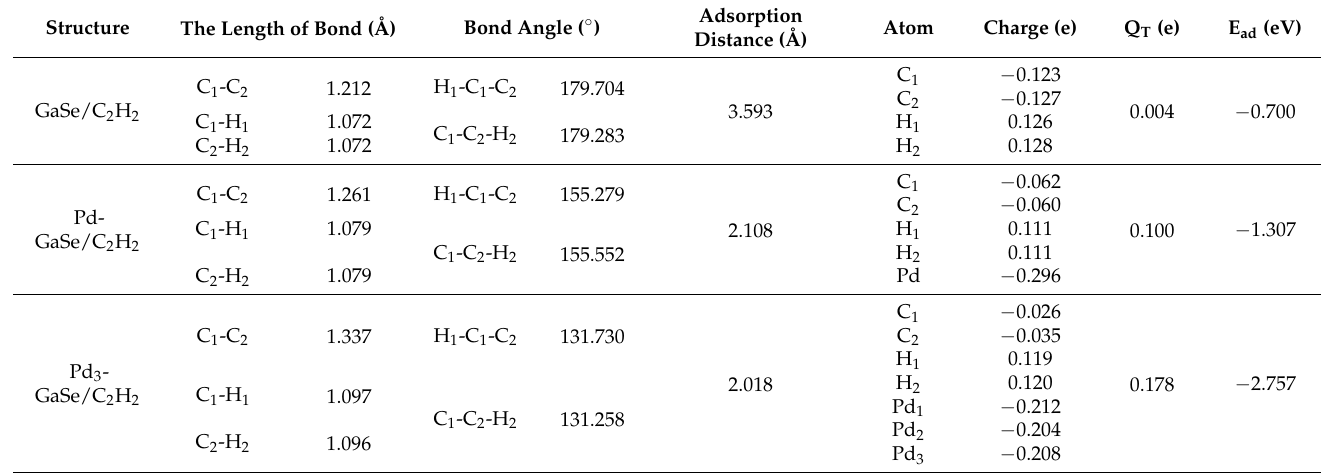
Table 3. Adsorption characteristic parameters of C 2 H 2